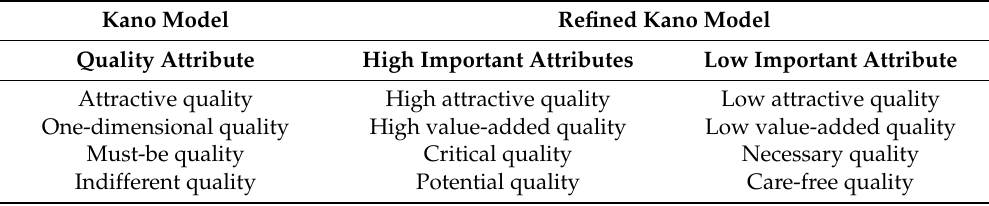
Table 2. Attribute definitions in the Kano model vs. the refined Kano